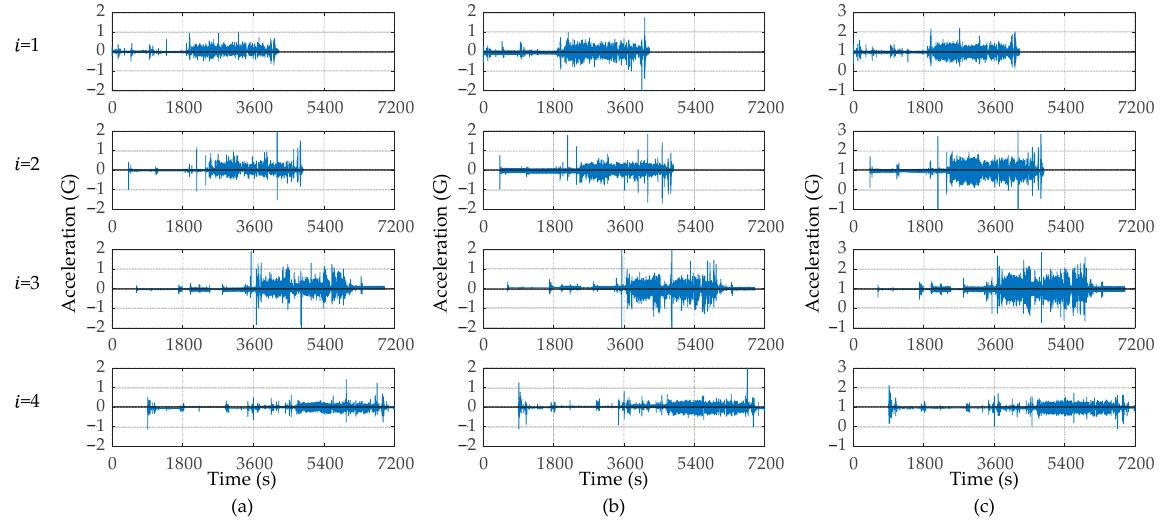
Figure 9. The vertical vibration on the route map: ( a ) 𝑖 = 1; ( b ) 𝑖 = 2; ( c ) 𝑖 = 3; ( d ) 𝑖 = 4.